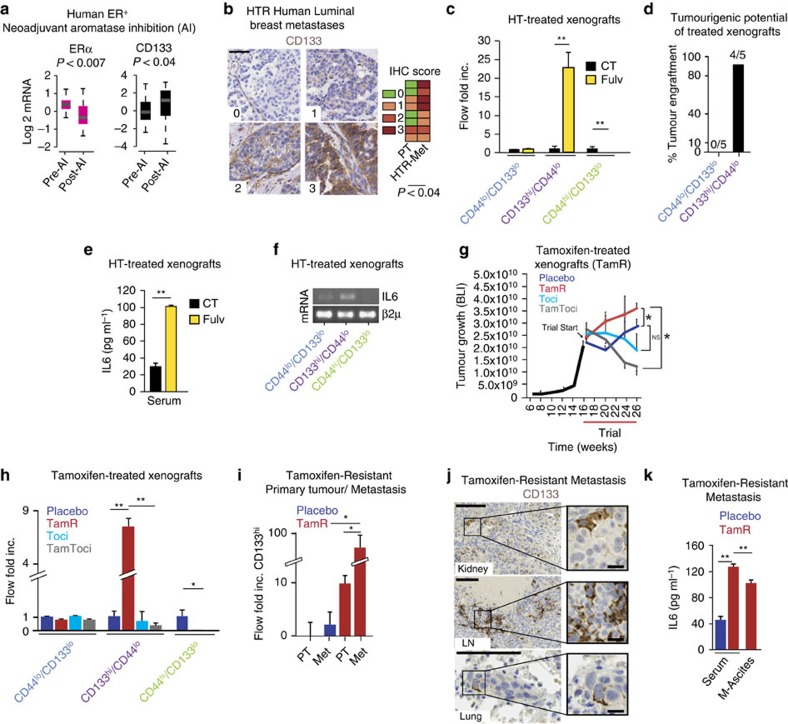
Increased CD133 and IL6 expression in HT-resistant cancers.(a) Box plot of CD133 and ERα mRNA levels (GSE1028) in breast cancer tissues pre- and post-Letrozole neoadjuvant treatment. P refers to Wald's test; each value corresponds to a patient sample (median, maximum and minimum values are reported). (b) CD133 expression [immunohistochemical (IHC) scores 0–3] in matched primary and metastatic tissues from patients who developed HTR metastasis (Supplementary Table 1). Representative images are shown (scale bar, 50 μM). (c) CD133 and CD44 cells from vehicle (CT) and fulvestrant (Fulv)-resistant MCF7 xenografts were quantified using flow analysis (Flow Fold Increase, n=4 per group, see Methods). (d) Bar graph of percentage of mice developing tumours (n=5 mice per group, tumour engraftment) from the injection of 100 Fulv-resistant ZR751-derived CD133hi/CD44lo or CD133lo/CD44lo cancer cells (P<0.001, Monte Carlo χ2-test). (e) IL6 levels were measured by ELISA from the serum of HT-resistant tumour-bearing mice (Fulv-resistant MCF7 tumours). (f) IL6 RT–PCR analysis from FACS-sorted populations derived from TamR-MCF7 tumours. Beta2 microglobulin (β2μ) mRNA is reported as quantitative control. (g) Representative growth kinetics (by bioluminescence (BLI)) of TamR-MCF7 tumours. MCF7 (GFP/Luciferase+) xenografts were established and mice were treated (n=5 per group) with tamoxifen citrate pellets (Tam, 5 mg per pellet) with/without tocilizumab (Toci) and in combination, TamToci. The mean BLI value±s.e.m. is reported for each time point. (h) MCF7 tumours from g were analysed for the expression of CD133 and CD44 using flow analysis (Flow Fold Inc is fold-increased as compared with placebo). (i) Flow Fold Increase (log-scale) of CD133hi cells derived from primary tumours and matched metastasis from TamR versus placebo mice. (j) Representative IHC images of CD133 protein expression in metastatic tissues (kidney, lymph node, lung) from TamR mice. Scale bar, 100 μm (inserts, 20 μm). (k) ELISA of circulating IL6 from TamR and placebo mice (malignant ascites, M-Ascites). Data are reported as mean±s.d. of three independent experiments (n=3, c,e,h,i,k). P values (*P<0.05, **P<0.0001) refer to Wilcoxon exact test (b), t-test (c,e), multiple comparisons corrected post hoc t-test after GLM analysis of variance (ANOVA; h,i,k), repeated measures GLM (g).